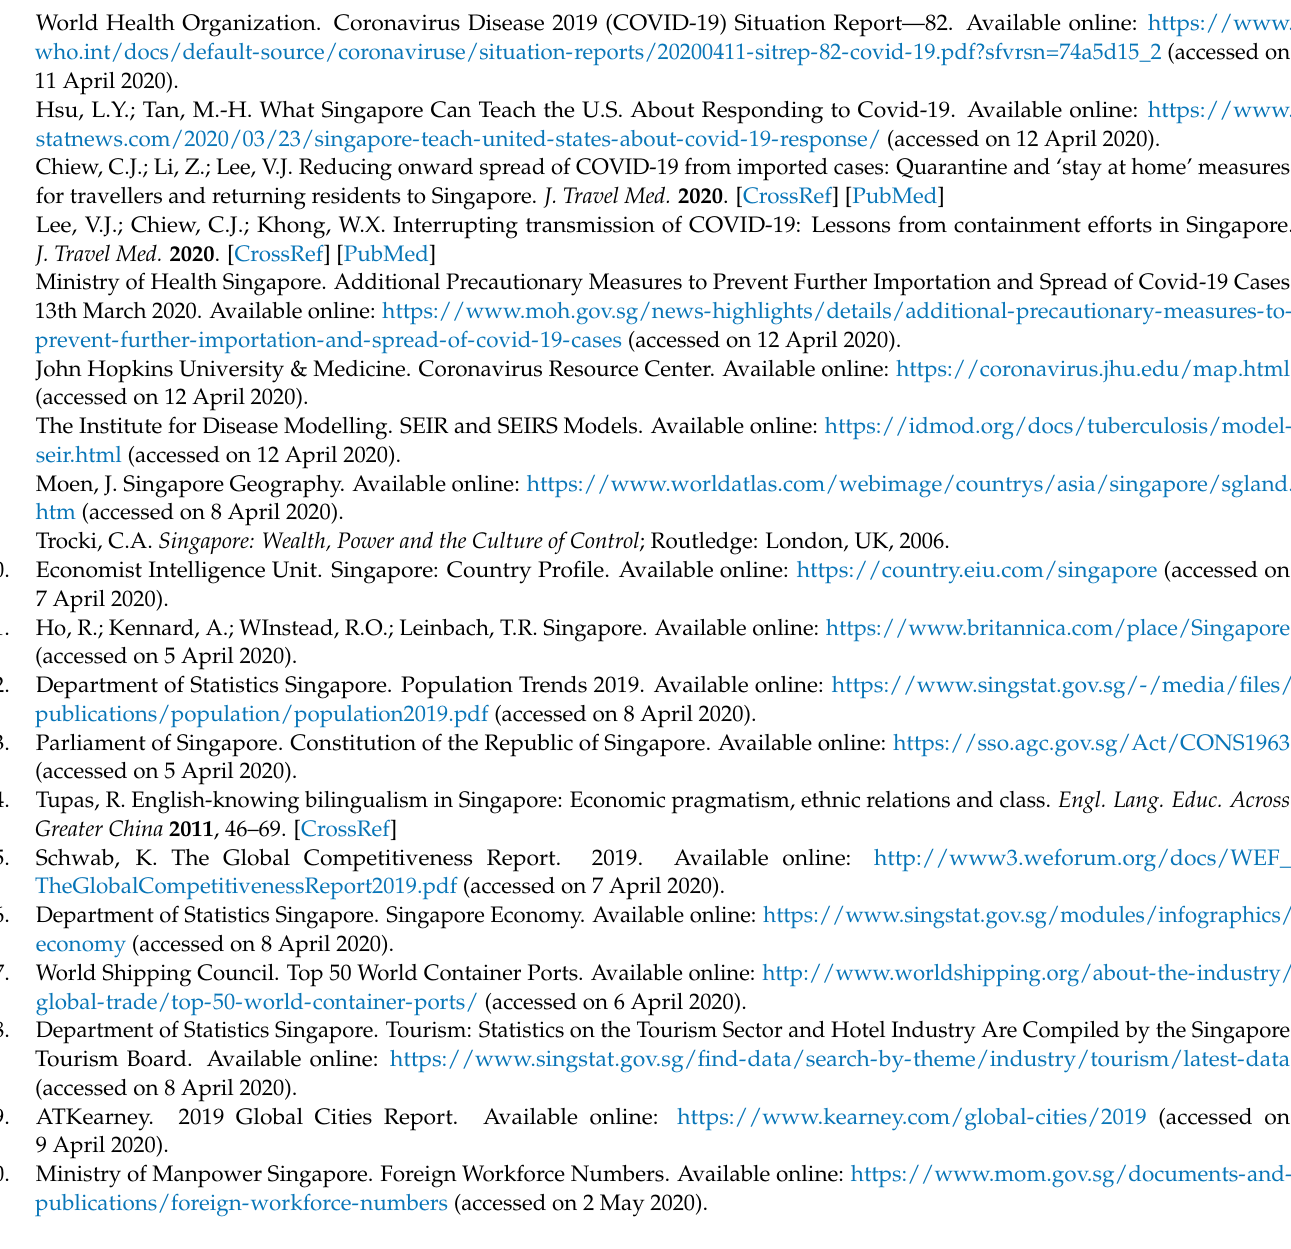
Singapore Ministry of Health and the WHO [68,69]. Last updated on 1 May